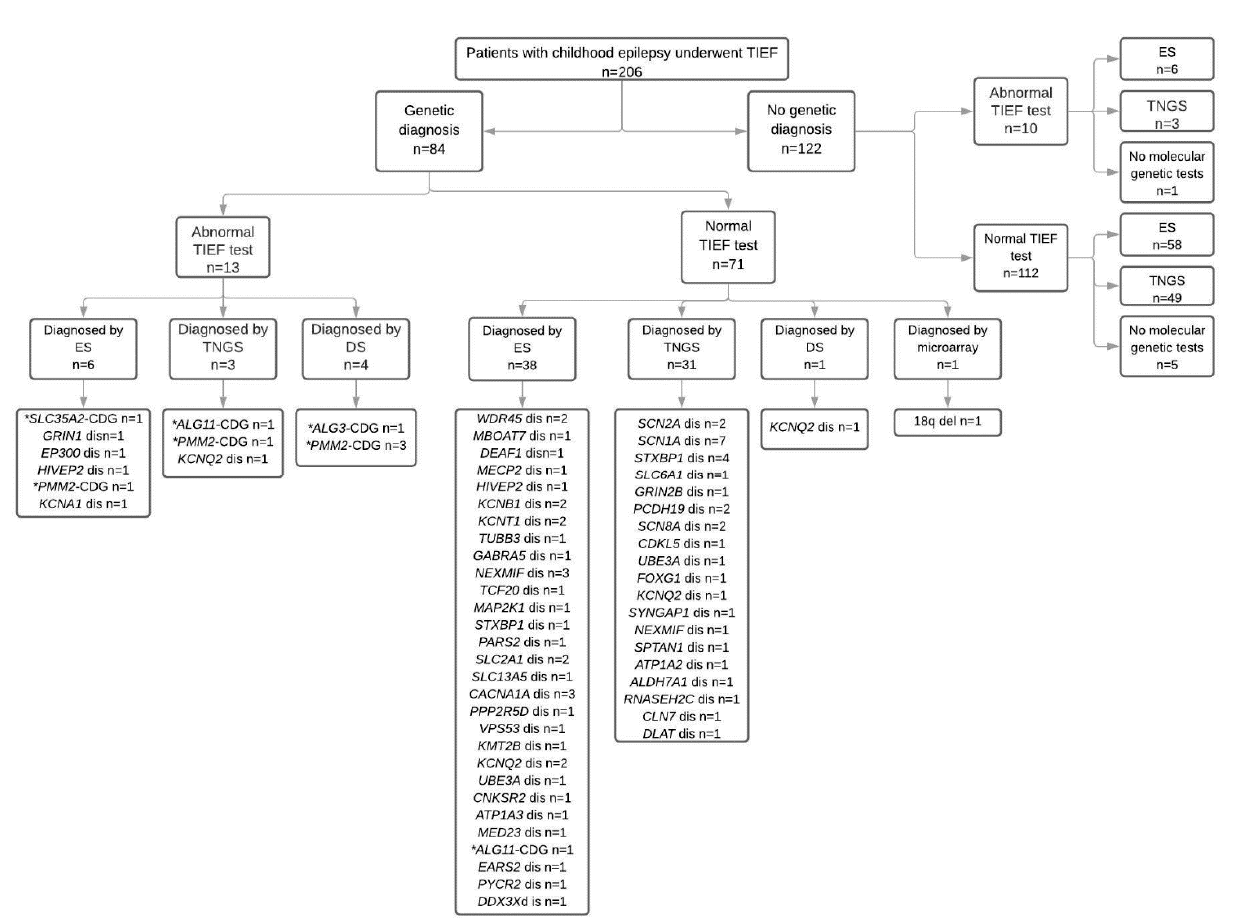
Figure 1. Number of patients with normal and abnormal TIEF tests, their genetic diagnosis and type of molecular genetic investigation are depicted in Figure 1. * Statistically significant.